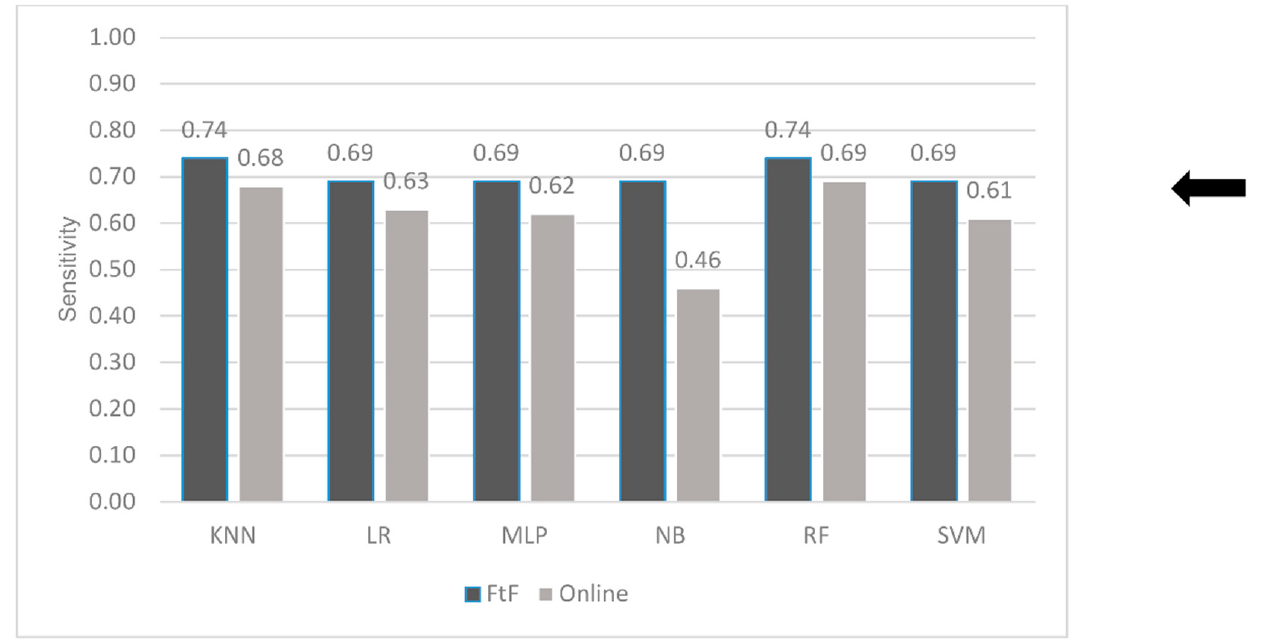
Figure 3. ACS course: prediction of at ‐ risk students (sensitivity scores) by instructional mode.